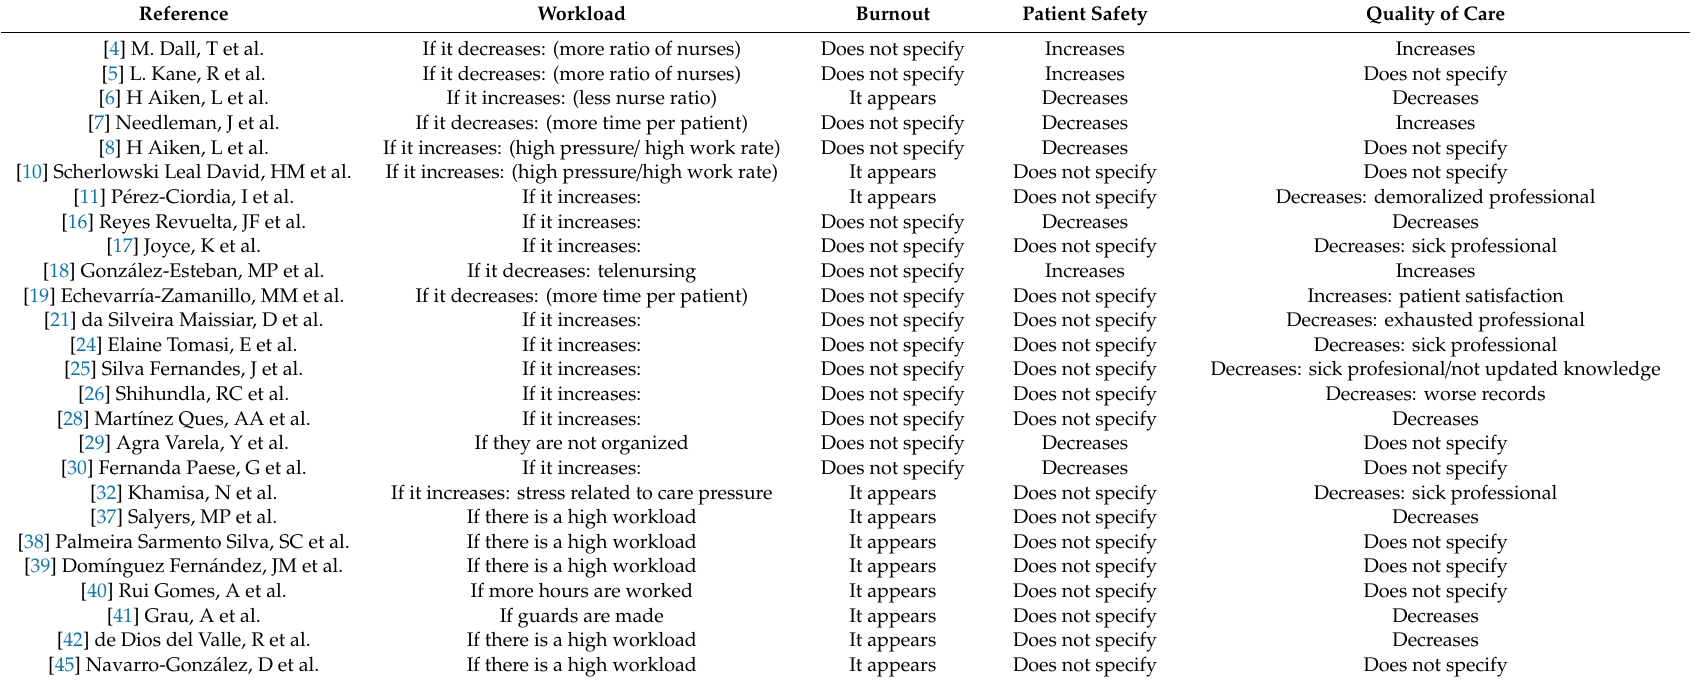
Table 3. Relationship between workload and burnout, patient safety and